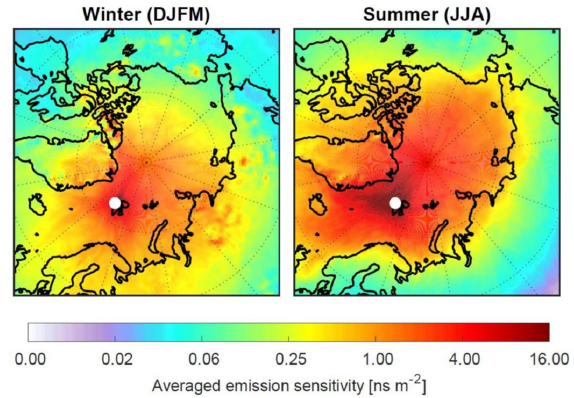
Figure 4. Footprint emission sensitivity for a black carbon tracer obtained from FLEXPART 50d backward calculations based on op- erational meteorological analyses for the period February 2014 to November 2018. The left panel shows the Arctic haze period (De- cember, January, February, March) and the right panel the summer period (June, July, August). The unit of the footprint is nanoseconds per square metre (nsm − 2 ), demonstrating that a longer residence time of an air mass over the surface leads to higher sensitivity to emissions. The concentration change at the receptor is the product of flux ×